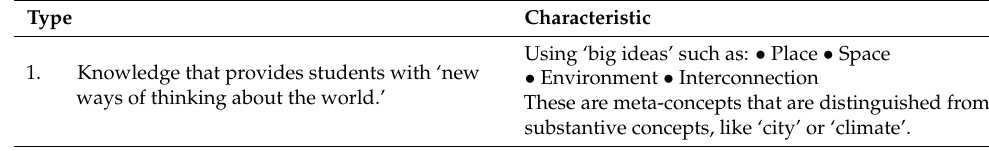
Table 2. A typology of geography’s powerful